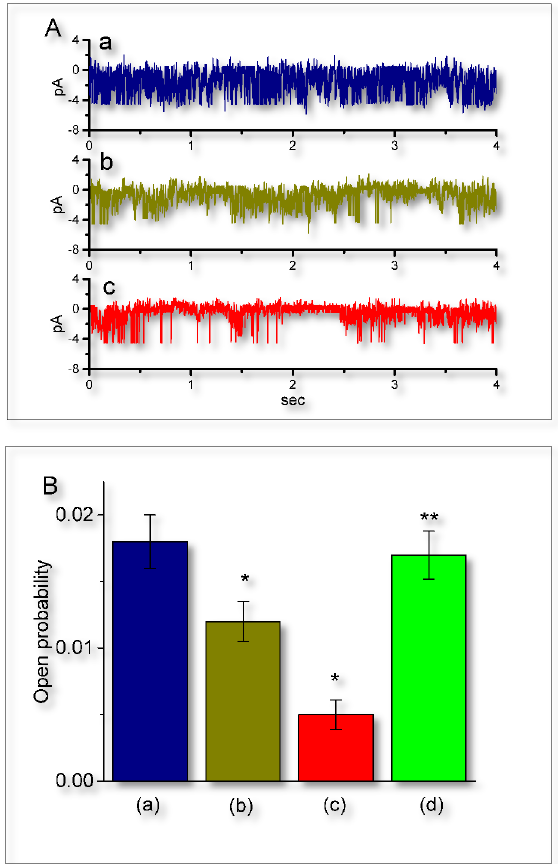
Figure 7. Suppressive e ff ect of UCL-2077 on the open probability of IK Ca channels in GH 3 cells. Under these experimental conditions, we suspended cells in normal Tyrode’s solution containing 1.8 mM CaCl 2 . The recording pipette was backfilled with K + -containing solution and we then performed cell-attached current recordings. ( A ) Original IK Ca -channel currents obtained in the control (a) and after application of 3 (b) and 10 µ M (c) UCL-2077. The potential was held at 0 mV relative to the bath. Notably, the downward deflection indicates channel openings. The time scale in the lower panel applies to all current trace. ( B ) Summary bar graph showing e ff ects of UCL-2077 and UCL-2077 plus 9-phenanthrol on the channel opening probability of IK Ca channels (mean ± SEM, n = 9 for each bar). a: control; b: 3 µ M UCL-2077; c: 10 µ M UCL-2077; and d: 10 µ M UCL-2077 plus 10 µ M 9-phenanthrol.